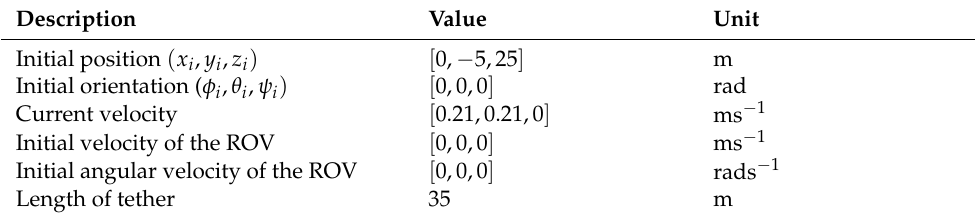
Table 8. Tether and ROV